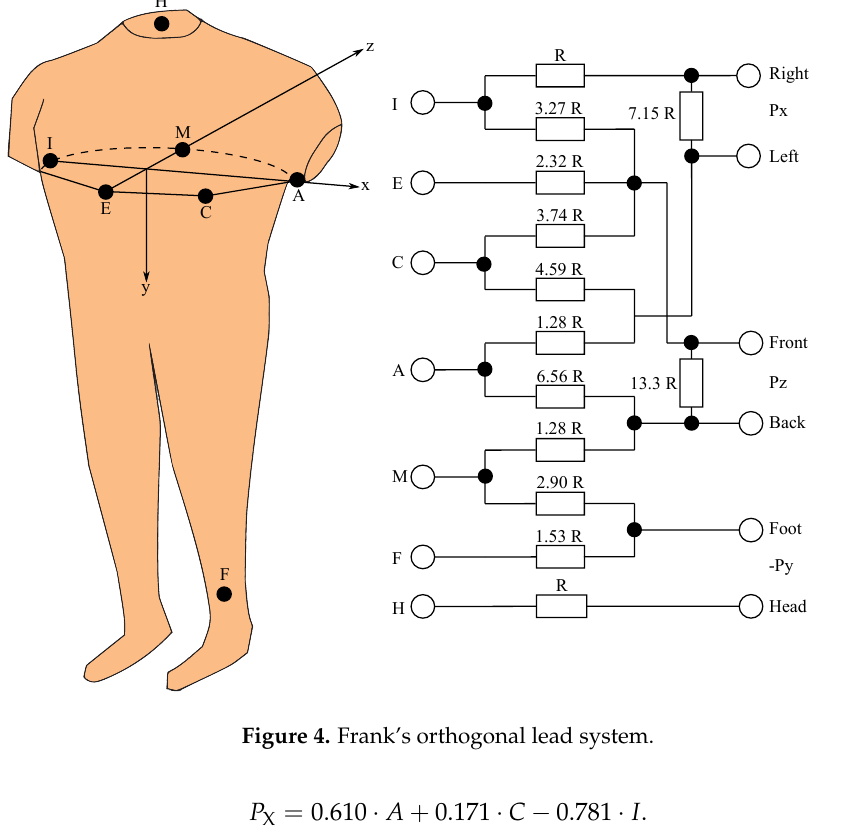
Figure 4. Frank’s orthogonal lead